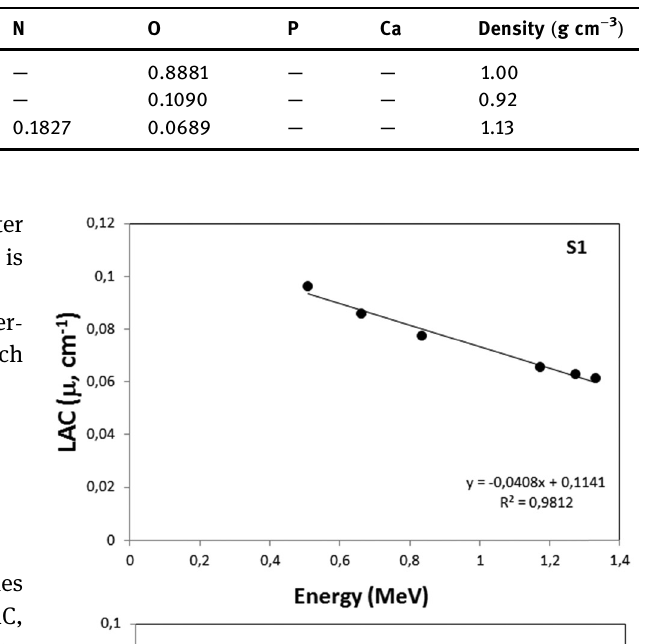
Table 1: Chemical contents of materials ( wt% ) [ 50 ]